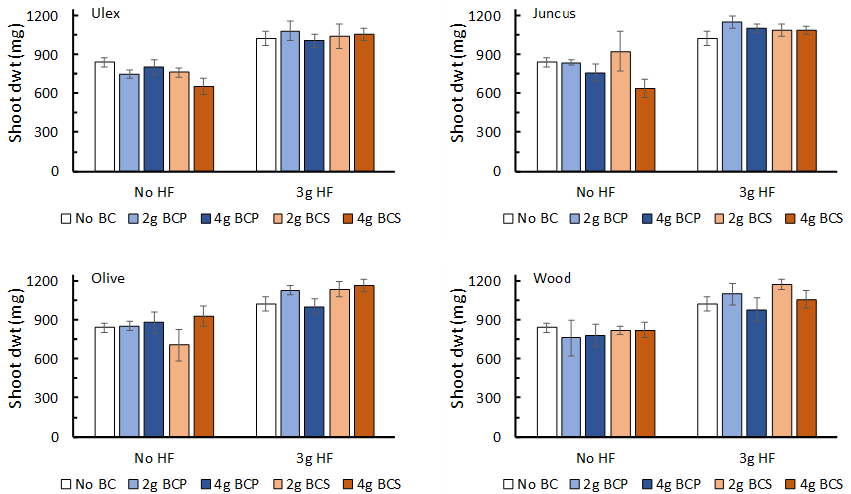
Figure 4. The response of barley (shoot dry weight, dwt; mean ± se; N = 8 per treatment) grown under greenhouse conditions to the addition of biochar created from four different feedstocks: Ulex sp., Juncus sp., olive stones and hardwood, and wood chips. Biochar was added to pots at three rates (0 g, 2 g, or 4 g per pot) and was added in two forms, powdered (BCP) and ‘sieved’ (BCS) , with grains between 3 – 7 mm. These biochar treatments were combined with the addition of HexaFrass at two rates (0 g and 3 g per pot) to produce ten treatments in total for each biochar. 3.4. Response of Barley and Oats to Biochar Application Rate with and without HexaFrass ™